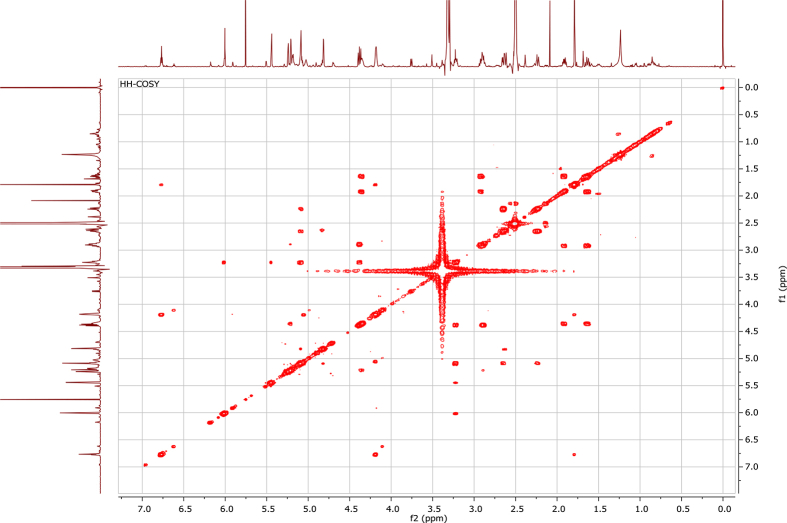
HH-COSY (DMSO-d6) spectrum of compound 13.